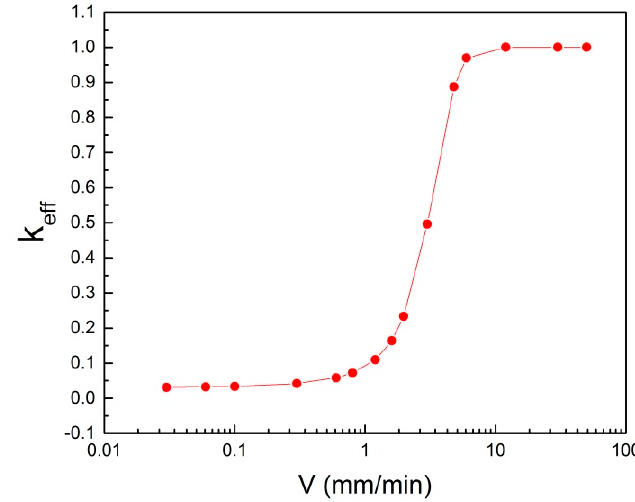
Figure 10. The relationship of k eff with crystal growth rate for the impurity, Fe, in aluminum